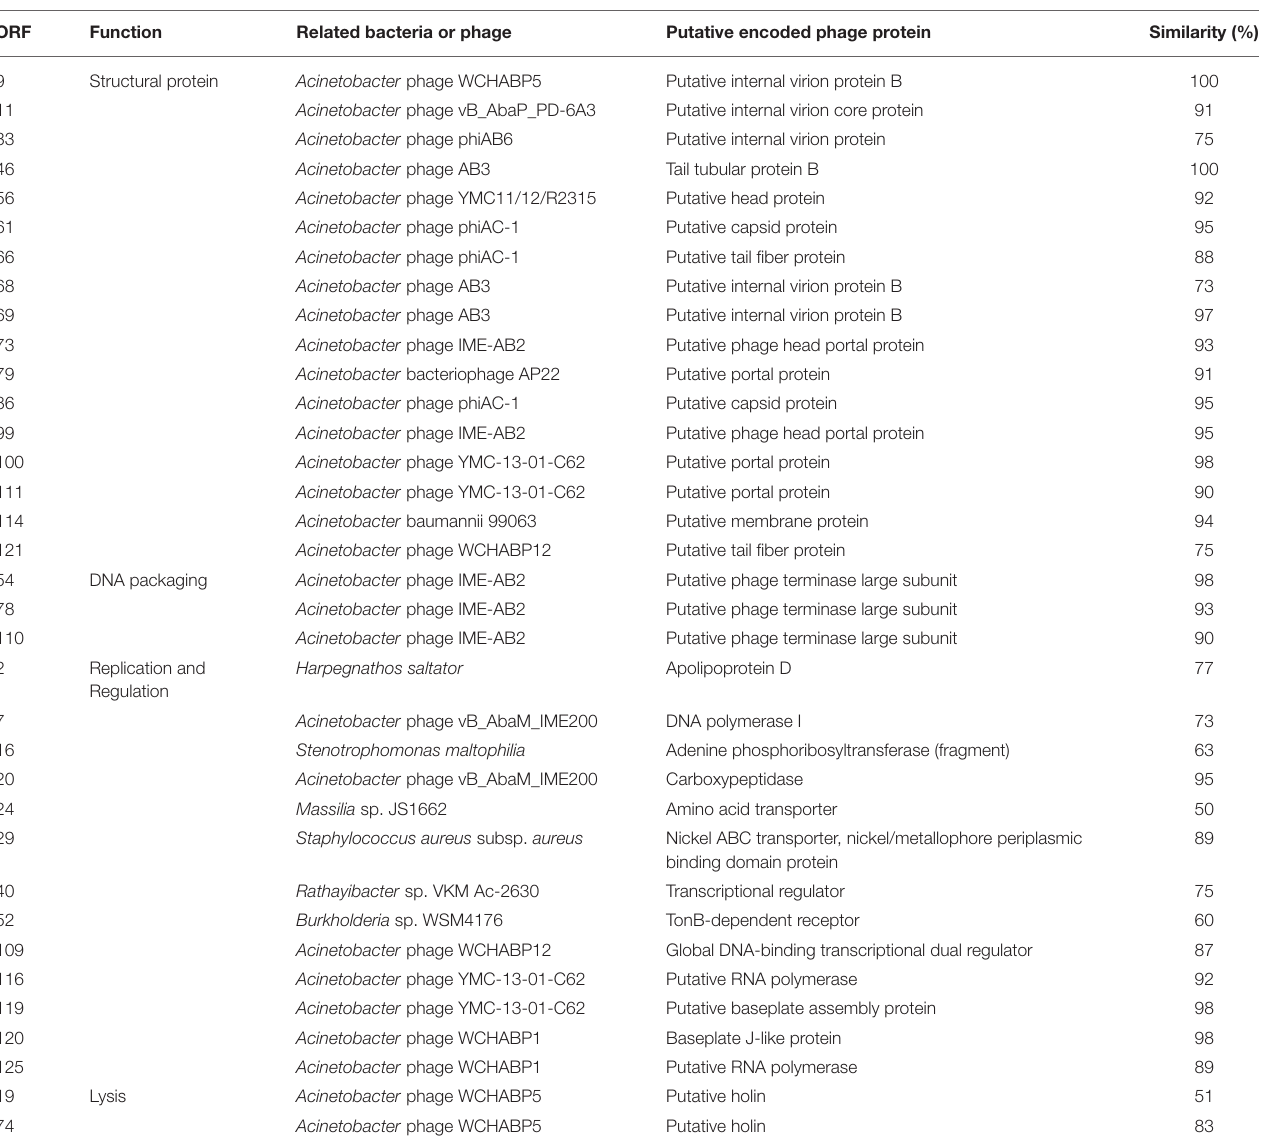
TABLE 2 | Functional annotation of putative ORFs found in bacteriophage PBAB08. ORF